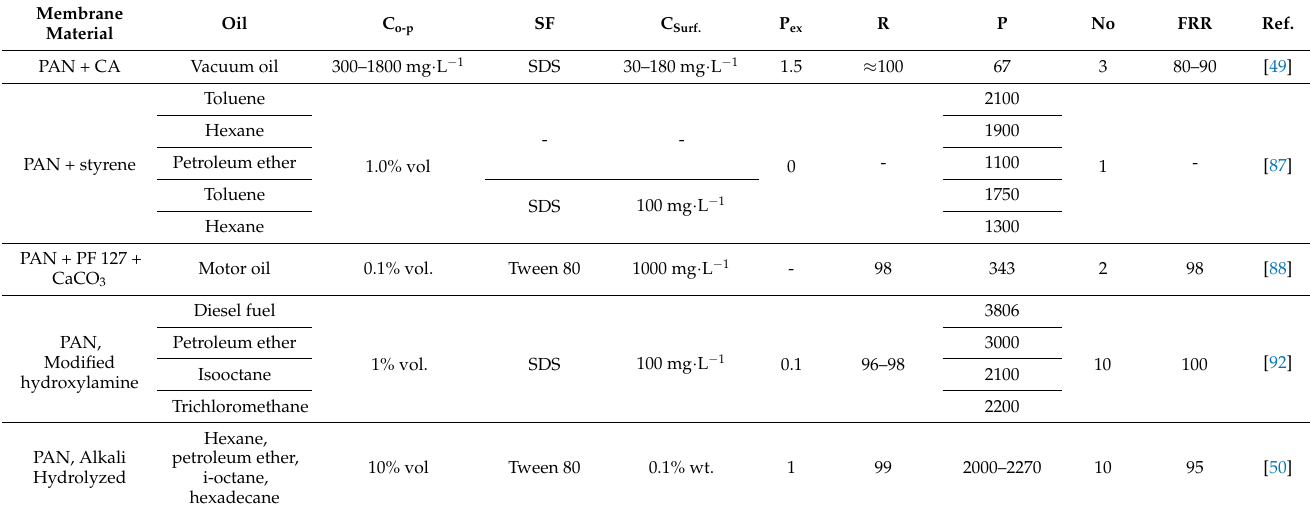
Table 4. PAN-based membranes for the separation of water-oil